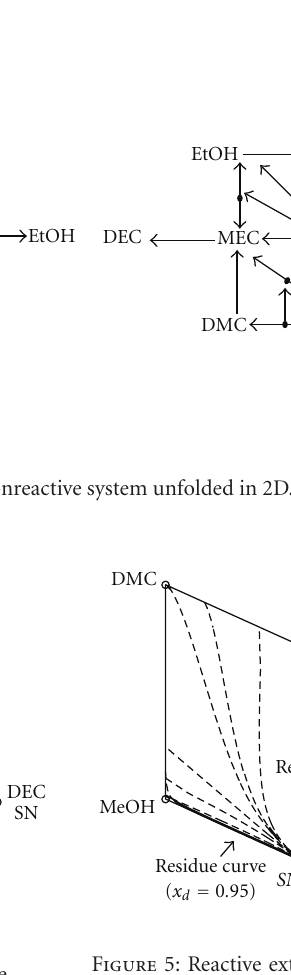
Figure 3: Residue curves in the transformed reactive space.